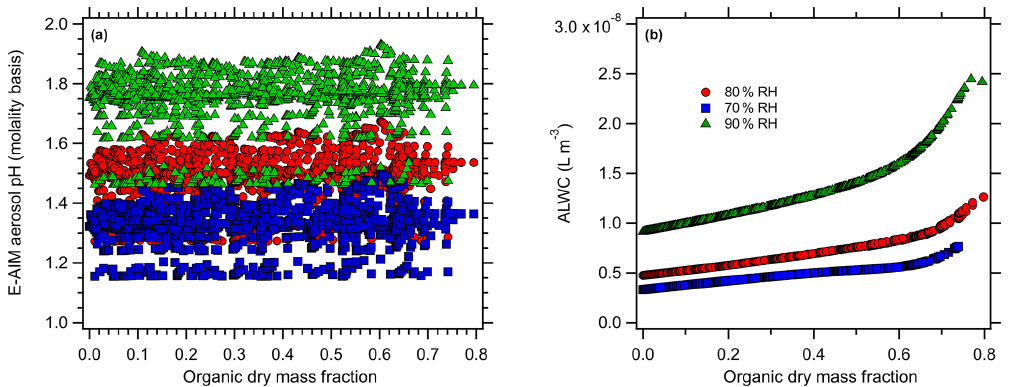
Figure 4. E-AIM-modeled (a) aerosol pH (molality basis) and (b) ALW at 70% (blue), 80% (red), and 90% RH (green) levels for the Baltimore simulations with organic acids.